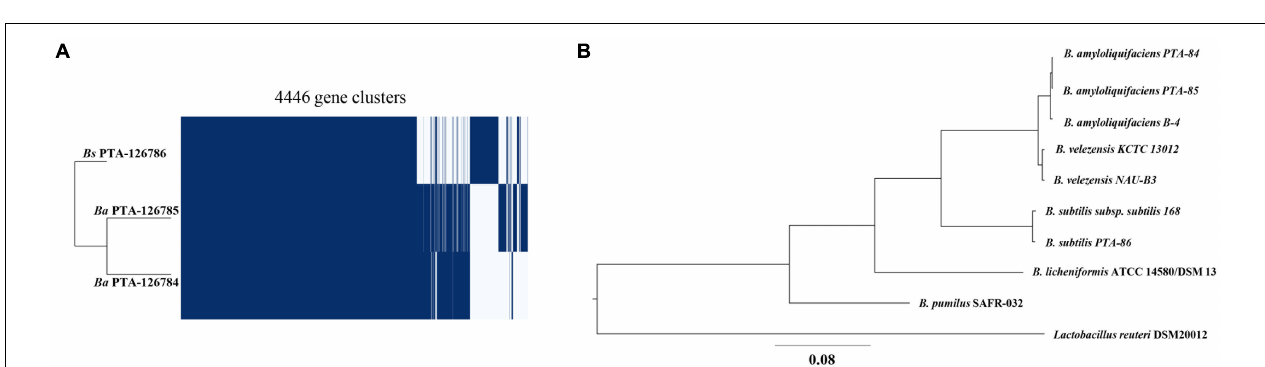
FIGURE 3 | Global untargeted metabolomic analysis of Ba PTA84, Ba PTA85, and Bs PTA86. (A) Principal component analysis of scaled metabolite intensities for culture supernatants in two different media. Black symbols represent media controls; numbers in parentheses indicate the variance explained by the first two principal components. (B) Like (A) , but for the culture cell pellets. (C) Number of identified secreted metabolites in culture supernatants in two different media (M) and (R), minimal and rich media, respectively. Secreted metabolites were defined as having a scaled intensity at least 1.5-fold higher than observed in media controls. Unique metabolites represent secreted compounds with abundances at least 1.5-fold higher than observed for other single strains (in the case of individual strain cultures) or corresponding individual strains (in the case of co-cultures). (D) Pathway representation of metabolites secreted by strains or strain combinations under minimal and rich media culture